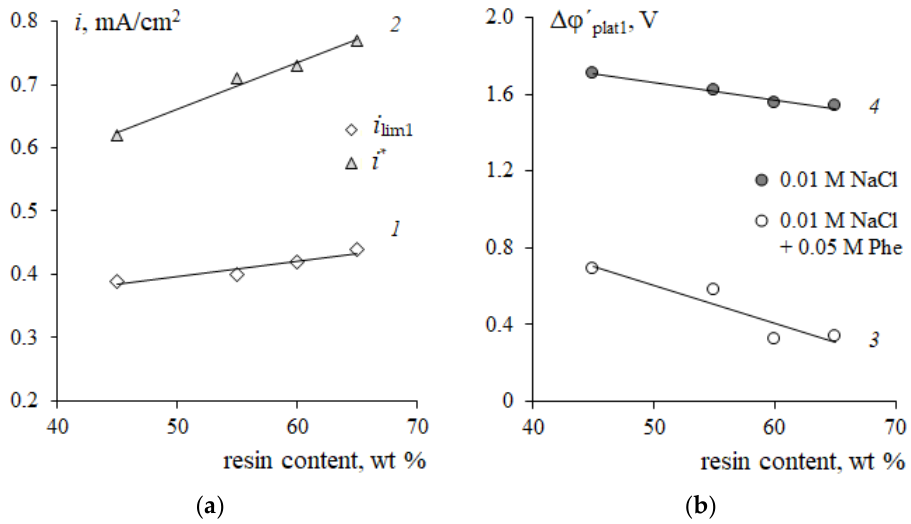
Figure 10. Dependences of the limiting current i lim1 ( 1 ), the current of onset of unstable electrocon- vection i * ( 2 ) ( a ), and the plateau length Δφ’ plat1 (3, 4) ( b ) on the CVCs of cation-exchange membranes in the 0.01 M NaCl solution ( 1 , 2 , 4 ) and in the 0.01 M NaCl + 0.05 M Phe solution ( 3 ) on the resin content.